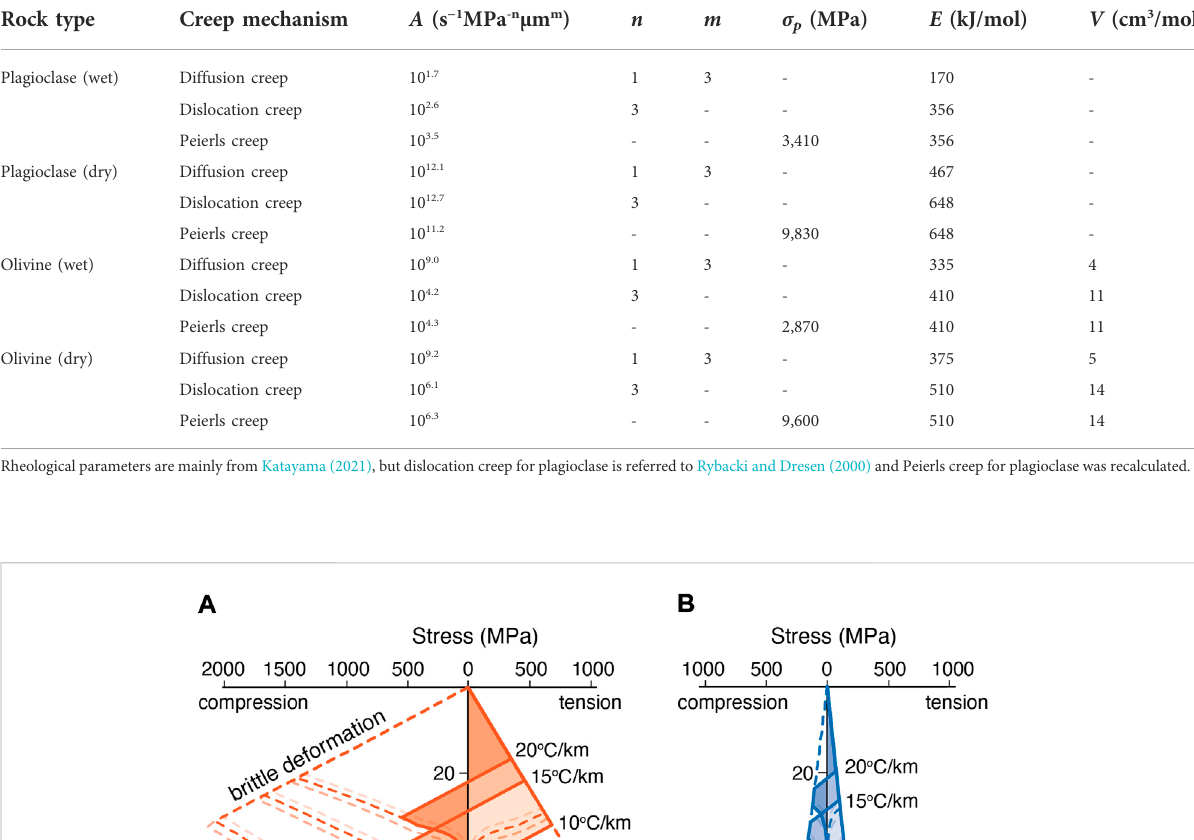
TABLE 1 Flow law parameters used to calculate plastic strength.